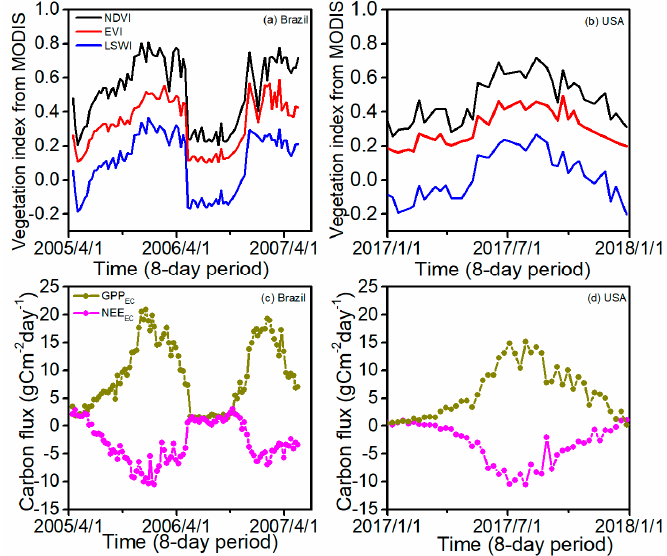
Figure 3. The seasonal variation in vegetation indices (Normalized Difference Vegetation Index (NDVI), Enhanced Vegetation Index (EVI), and Land Surface Water Index (LSWI)) derived from the MODIS images and the measured NEE EC and the estimated GPP EC at the two sugarcane EC tower sites (8-day interval). ( a ) and ( c ), Brazil site, 2005–2007; ( b ) and ( d ), Louisiana site, USA, 2017.